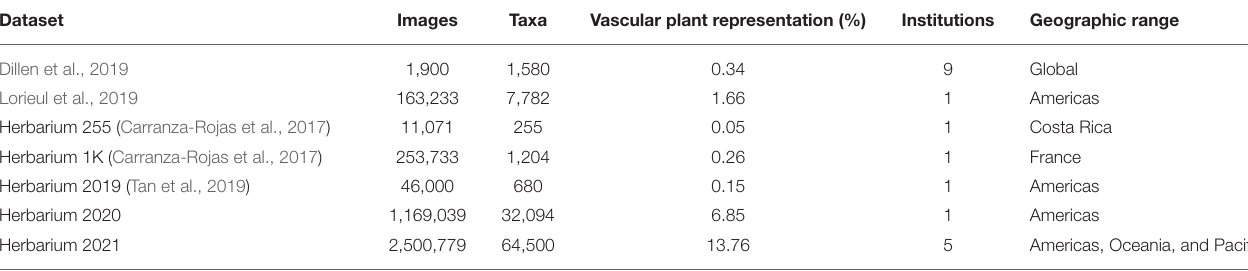
TABLE 1 | Summary of existing herbarium sheet image datasets.